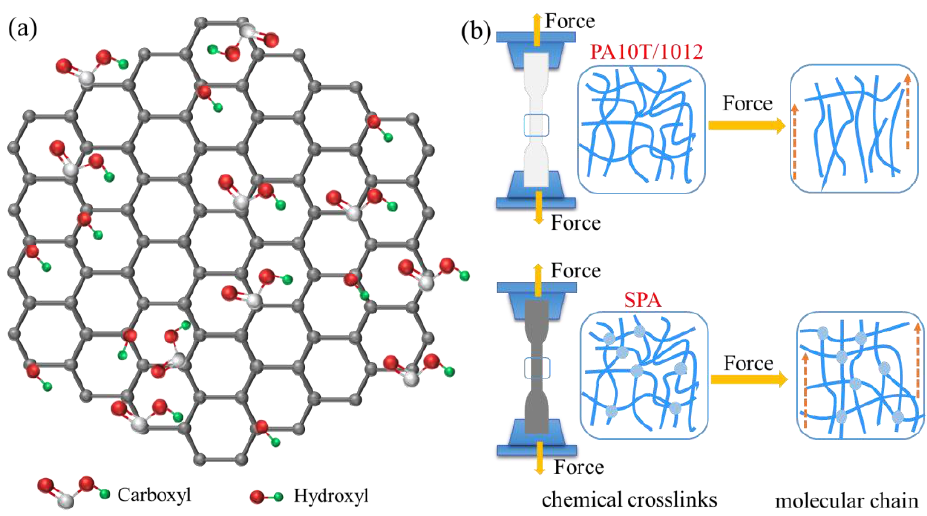
Figure 12. ( a ) Structure model of GO; ( b ) Tensile deformation mechanism.